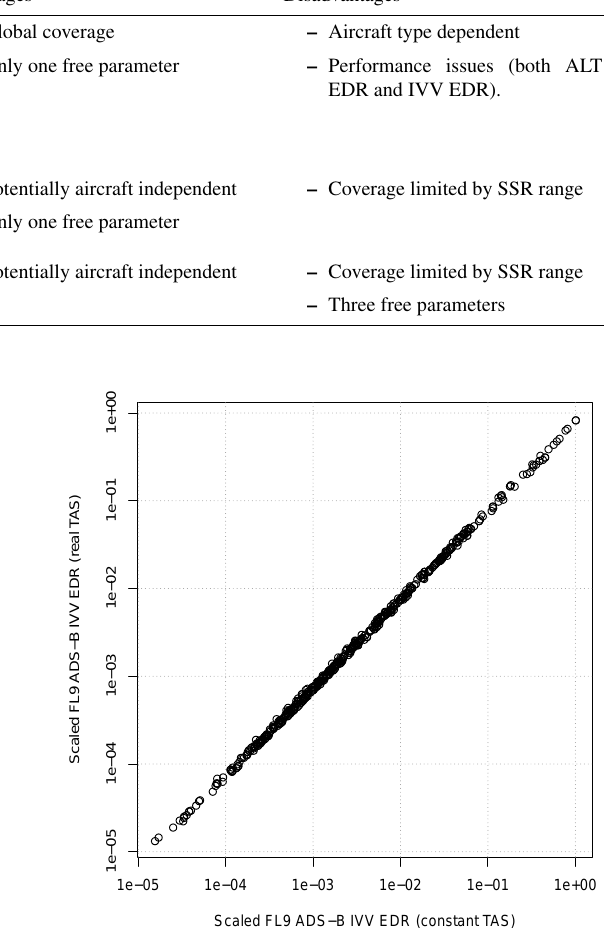
Figure 10. An exemplary comparison of EDR for FL9 calculated using IVV method using the real TAS record vs. the constant TAS approximation. We used 250ms − 1 as the constant TAS. Both of the EDR estimates were scaled to the range of values of constant TAS EDR thus are unitless and in approximate range